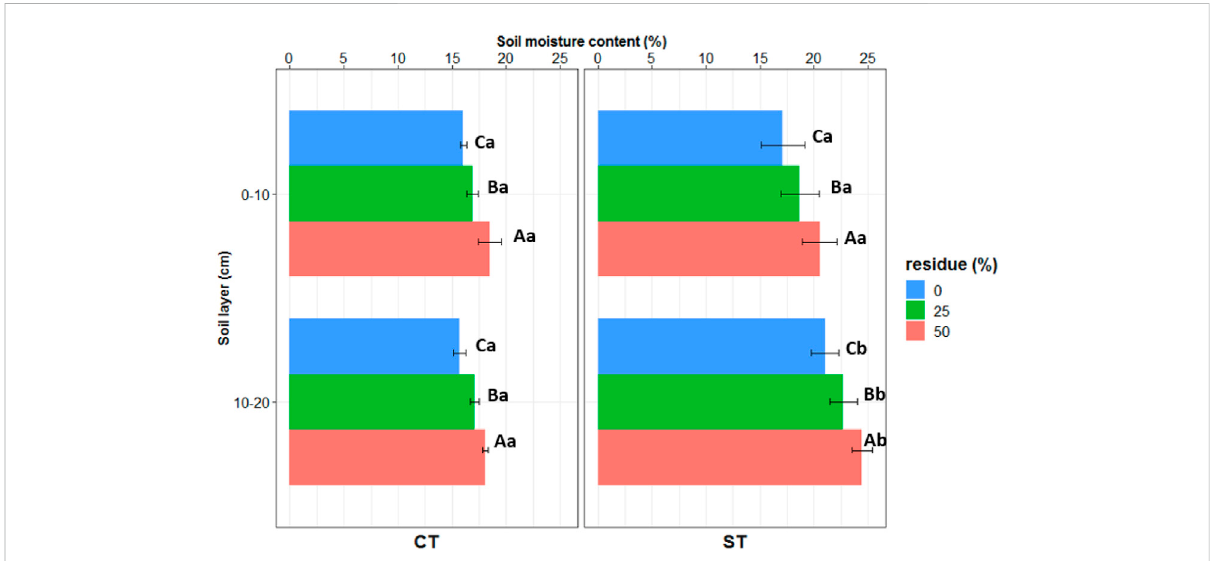
FIGURE 5 Effect of tillage and crop establishment (TCE) techniques and residue management (R) options on soil moisture content (SMC) at 0 – 10 and 10 – 20 cm pro fi le depths at maize harvest in 2020 – 21. For treatment, details refer to Table 2. Different upper-case letters represent signi fi cant intragroup statistical difference at p ≤ 0.05; Different lower-case letters represent signi fi cant intergroup statistical difference at p ≤ 0.05; p values calculated by the ANOVA test and t